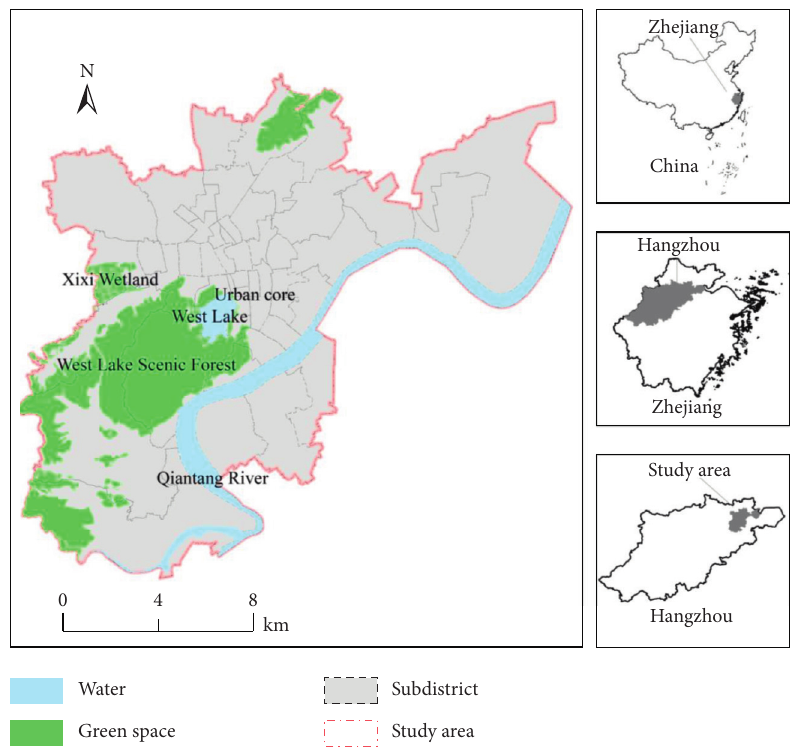
Figure 1: The locations of study